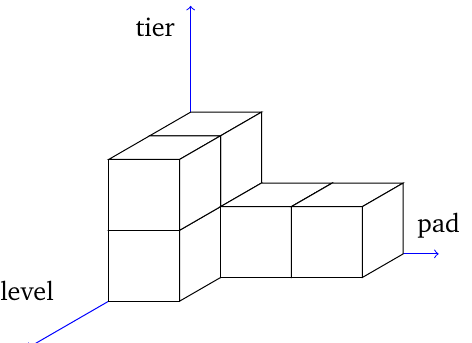
Figure 15: Visualization of the three-dimensional Young diagram partitioning of free- fermionic Hilbert space. We use such diagrams to visualize exploration of the space. Each block is defined by a level, pad and tier, and represents a set of states, disjunct from other